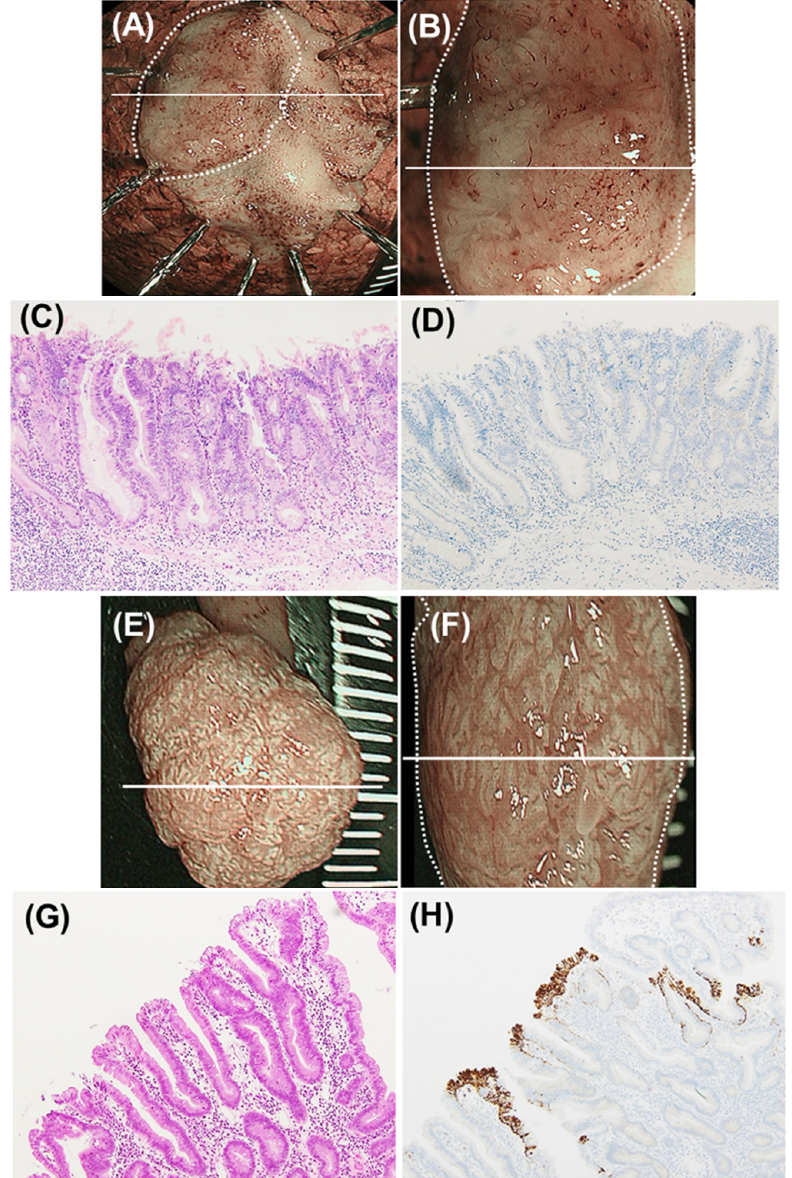
Figure 2. Representative images of milk-white mucosa (MWM)-positive and -negative superficial non-ampullary duodenal epithelial tumor (SNADET) lesions. ( A – D ) Representative images of a SNADET of high-grade intraepithelial neoplasia (HGIN). ( A ) Narrow band imaging (NBI) endoscopic image of an endoscopically resected specimen. The white line indicates the maximal section. The endoscopic MWM-positive rate was 0% (non-entire type). ( B ) NBI magnification endoscopic image of the resected specimen. The white line indicates the maximal section. ( C ) Histology of the maximal section (hematoxylin-eosin (HE) staining). ( D ) Immunohistochemical finding of the maximal section (adipose differentiation-related protein (ADRP) staining). Neoplastic epithelial cells were all negative for ADRP staining. ( E – H ) Representative images of a SNADET of low-grade intraepithelial neoplasia (LGIN). ( E ) NBI endoscopic image of an endoscopically resected specimen. The white line indicates the maximal section. The endoscopic MWM-positive rate was 95% (entire type). ( F ) NBI magnification endoscopic image of the resected specimen. The white line indicates the maximal section. ( G ) Histology of the maximal section (HE staining). ( H ) Immunohistochemical finding of the maximal section (ADRP staining). Most neoplastic epithelial cells (90%) were positive for ADRP staining.